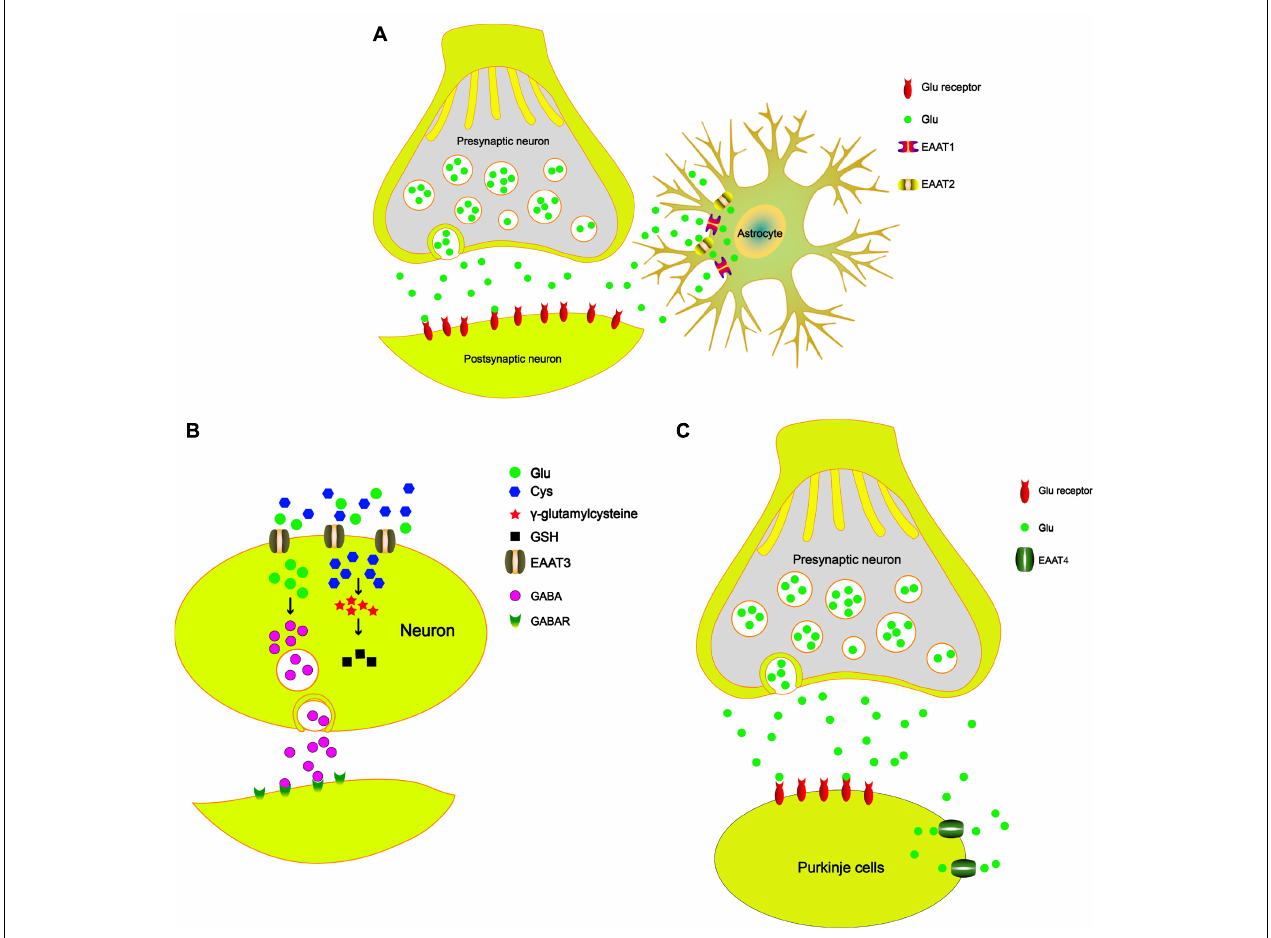
FIGURE 1 | The role of EAATs in the PD model. (A) The tripartite synapse is composed of the presynaptic neuron, postsynaptic neuron, and astrocytes. EAAT1 and EAAT2 uptake Glu from the synaptic cleft to maintain Glu homeostasis and prevent the excitotoxicity of neurons. (B) EAAT3 uptakes Cys and then synthesizes GSH, which reduces oxidative damage. EAAT3 modulates GABA synthesis and maintains GABA homeostasis. (C) EAAT4 plays a key role in the synaptic activity of cerebellar Purkinje cells by regulating extracellular Glu